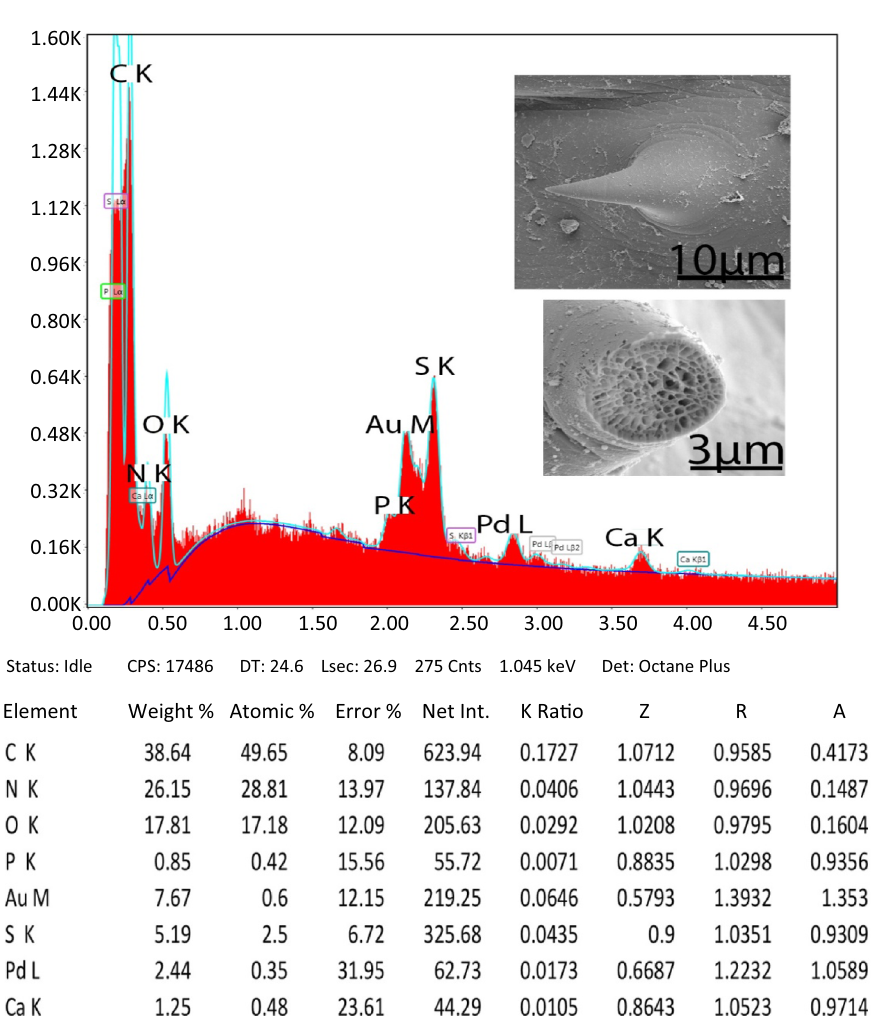
Figure 25. The printout for the elemental scan (EDXA) of a spine from the posterior fi eld of spines in the foretrunk of Neoandracantha peruensis . Note values for spines in the other 2 fi elds in Table